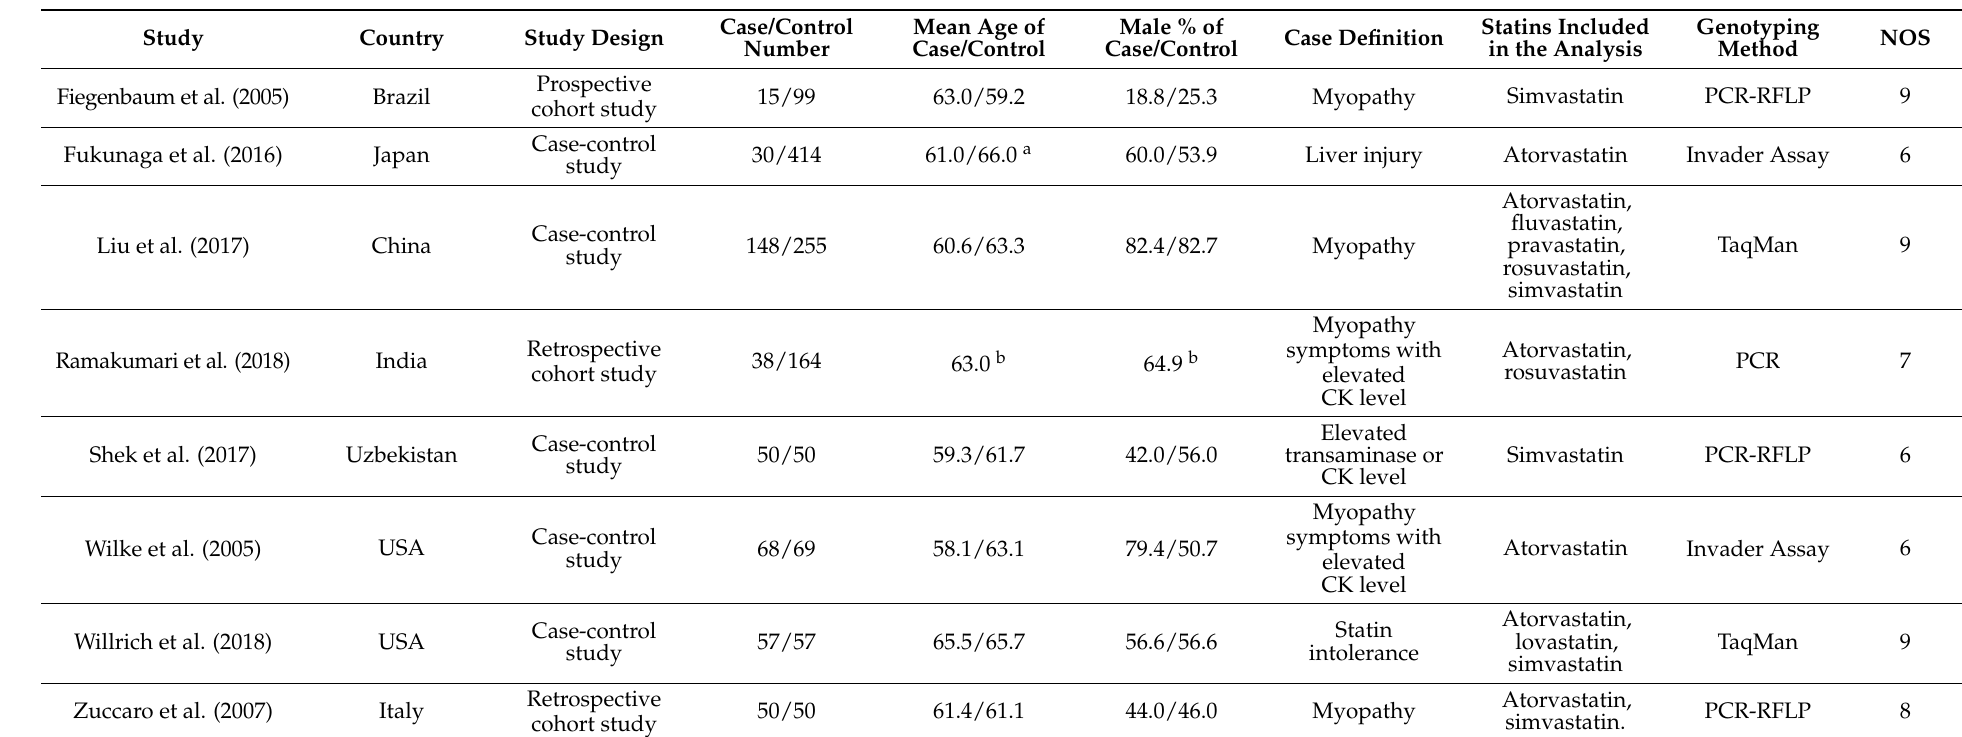
Table 1. Characteristics of the studies